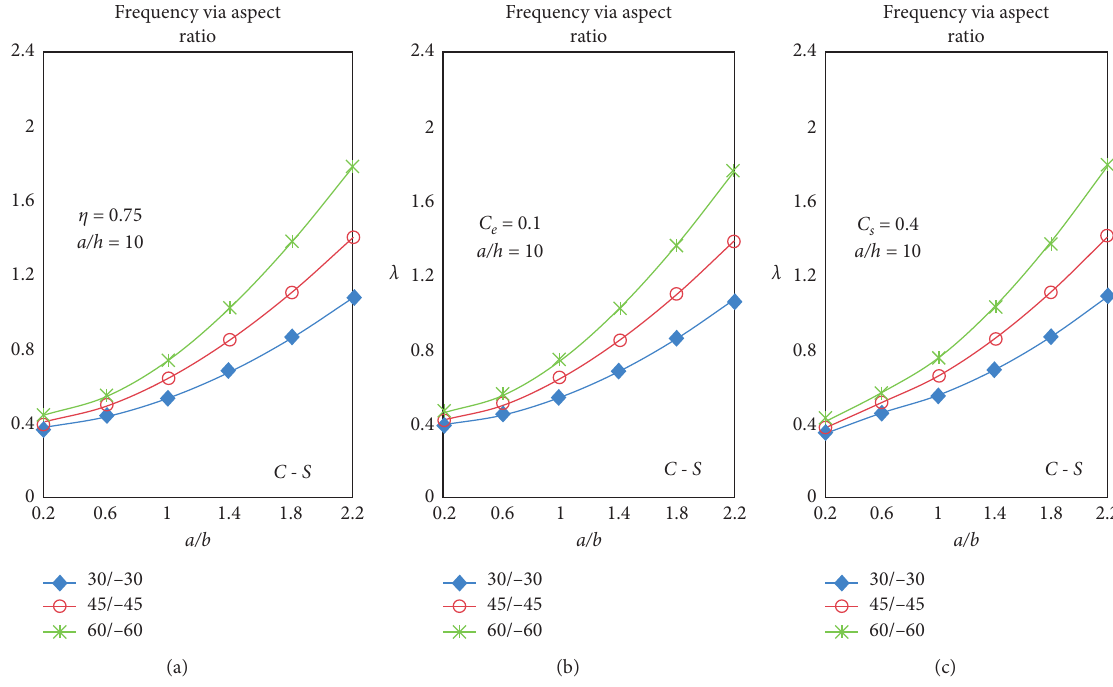
Figure 12: Influence of aspect ratio on frequency parameter value of 3-layered plates under C-S support